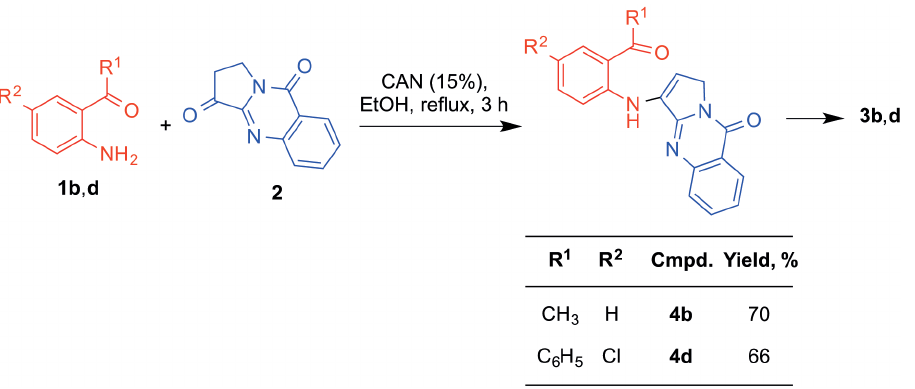
Figure 4. Isolation of open luotonin analogues that behave as intermediates of the Friedla¨nder reaction. By interrupting the reaction at mid-course, it was possible to isolate enamines 4 and prove their role as intermediates of the Friedla¨nder reaction by verifying that they afforded the final products under our standard conditions.